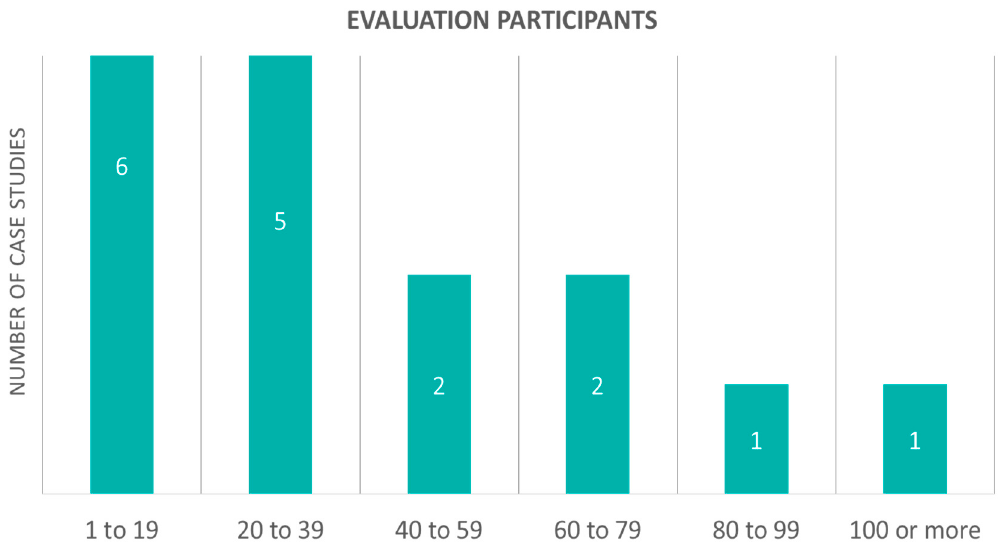
Figure 10. Case studies with evaluation according to their participant number.